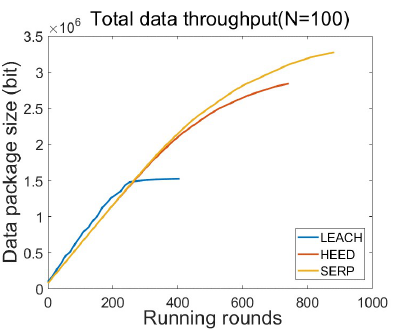
Figure 9. Total data throughput when the number of nodes N = 100.